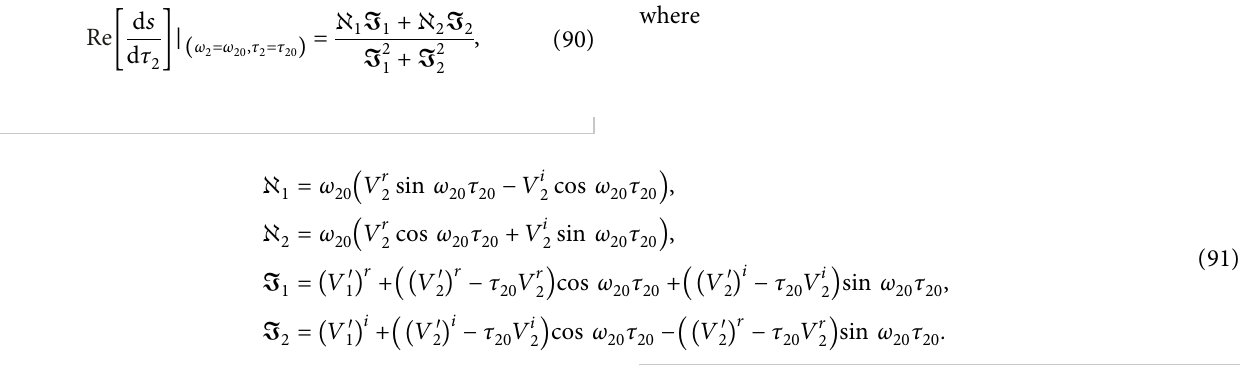
Figure 3: Case 2: the trajectories and phase diagrams of system (92) over time at τ